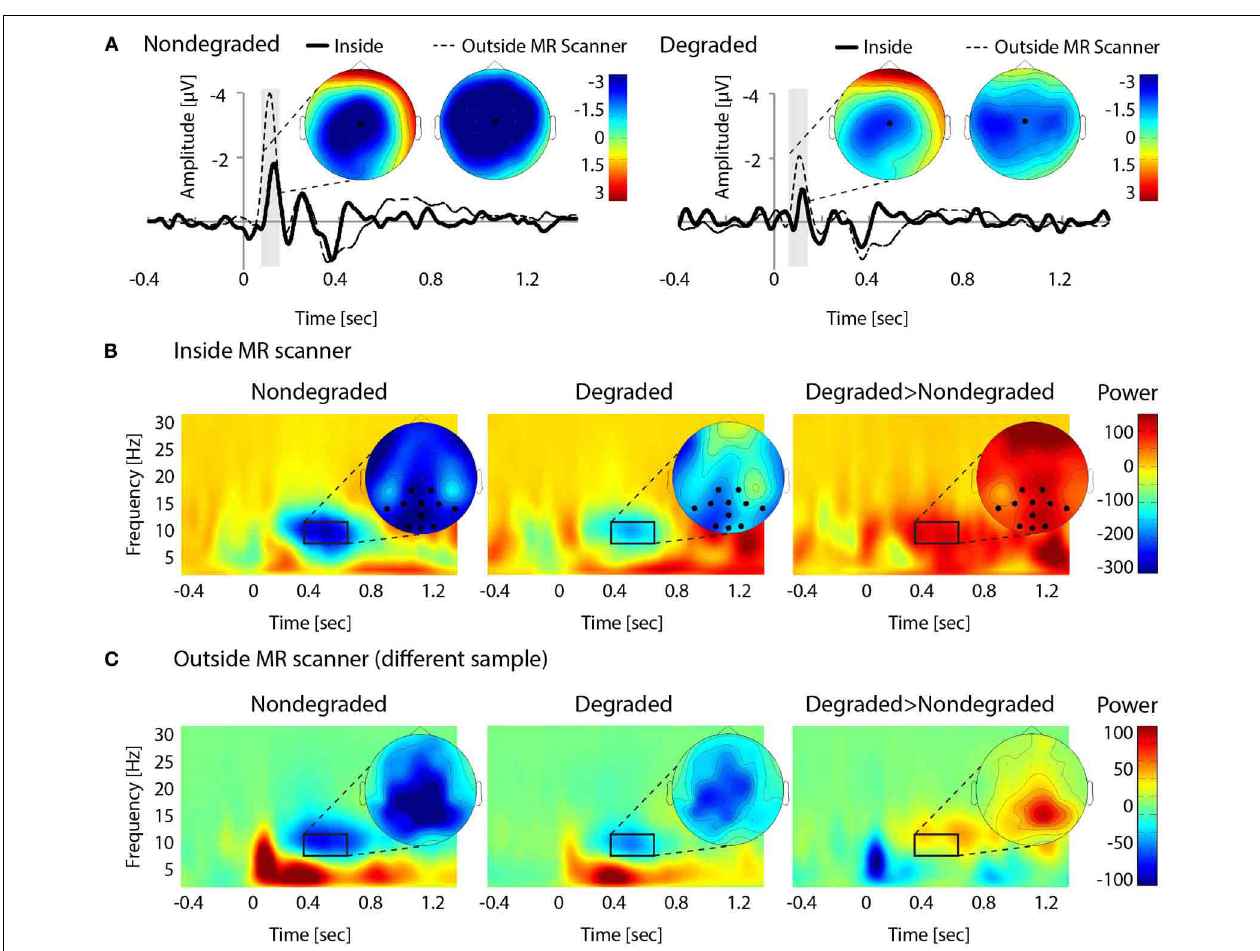
FIGURE 2 | EEG results. (A) Grand-average of evoked responses in the nondegraded (left) and degraded (right) condition. ERP-differences between conditions were seen for the N1, with a central/midline distribution (100–150ms, indicated by gray bars). (B) Averaged time-frequency representationsforthenondegraded(left)anddegraded(middle)condition,and difference between averages (degraded > nondegraded; right). The strongest effectofalphasuppression(comparedtobaseline)occurredatcentral-posterior